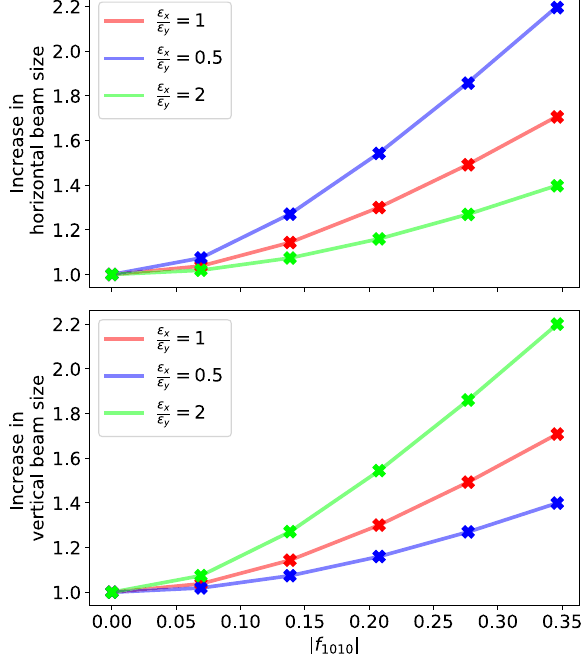
FIG. 4. Increase of beam size in IP1 as a function of the absolute value of the coupling